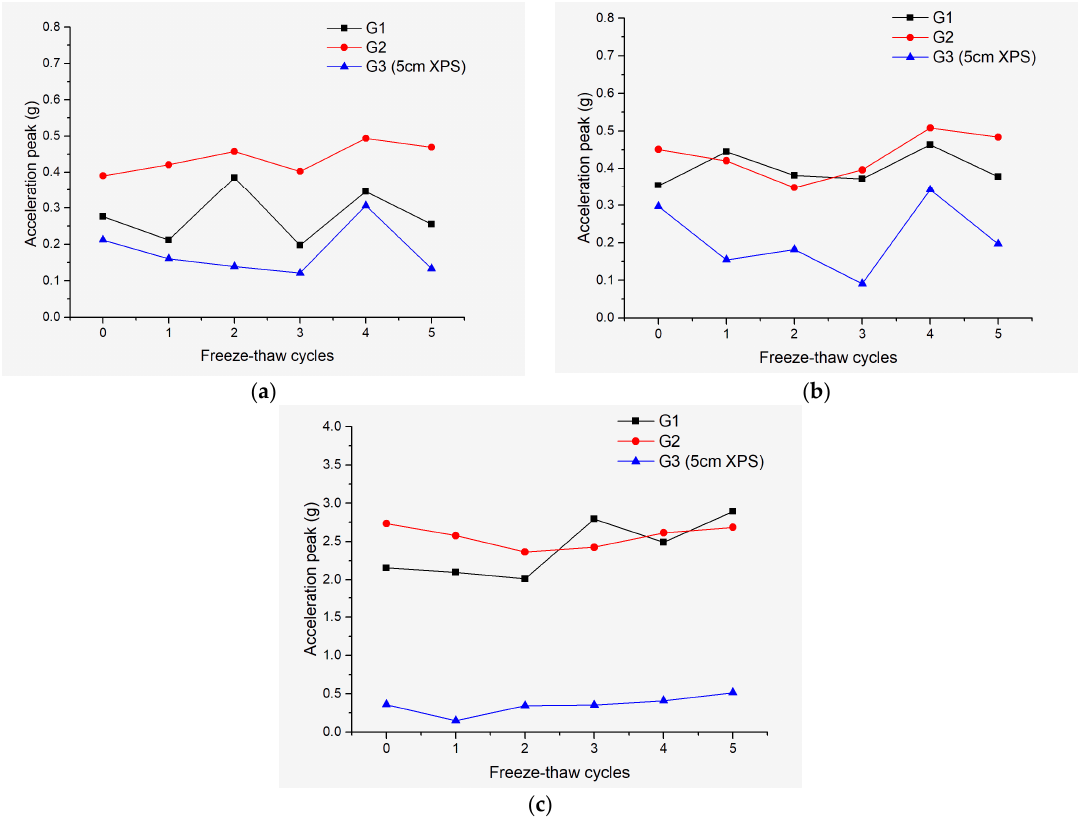
Figure 9. Acceleration peak of the three test groups after freeze–thaw cycles. ( a ) Acceleration peak in the X-direction; ( b ) Acceleration peak in the Y-direction; ( c ) Acceleration peak in the Z-direction.